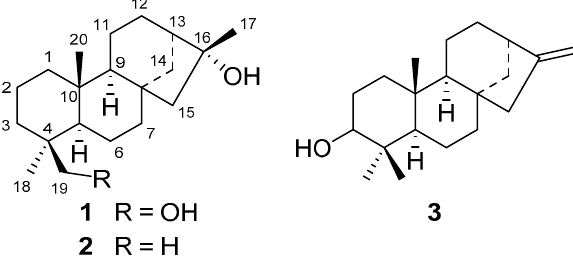
Figure 1 . Chemical structures of phyllocladanes 1 – 3 from Acacia schaffneri .